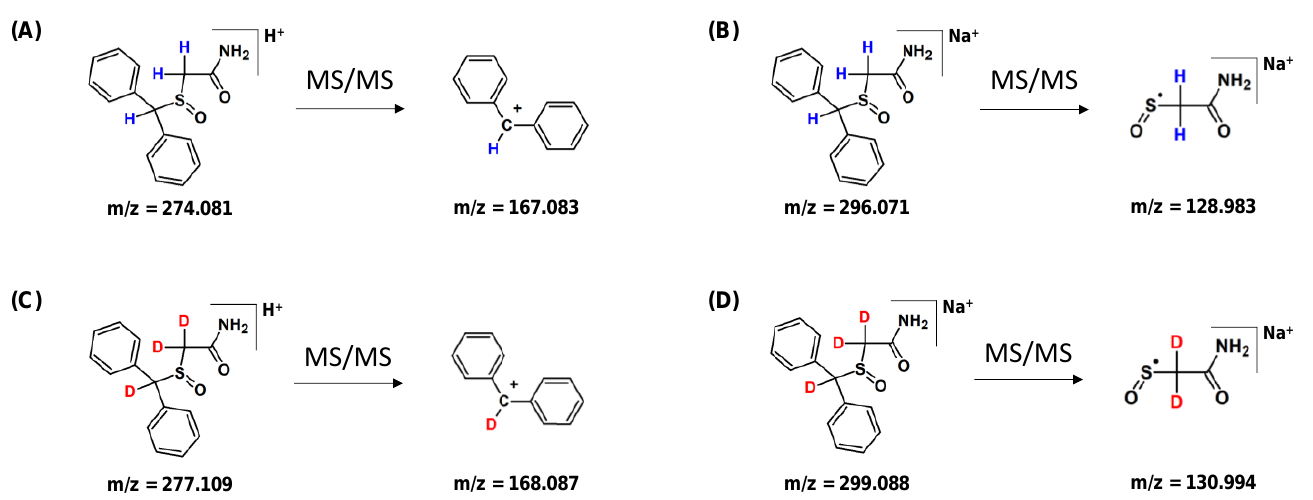
Figure 5. Fragmentation pathways of ( A ) protonated armodafinil, ( B ) armodafinil sodium adduct, ( C ) protonated armodafinil-d 3 , ( D ) sodium adduct of armodafinil-d 3 .